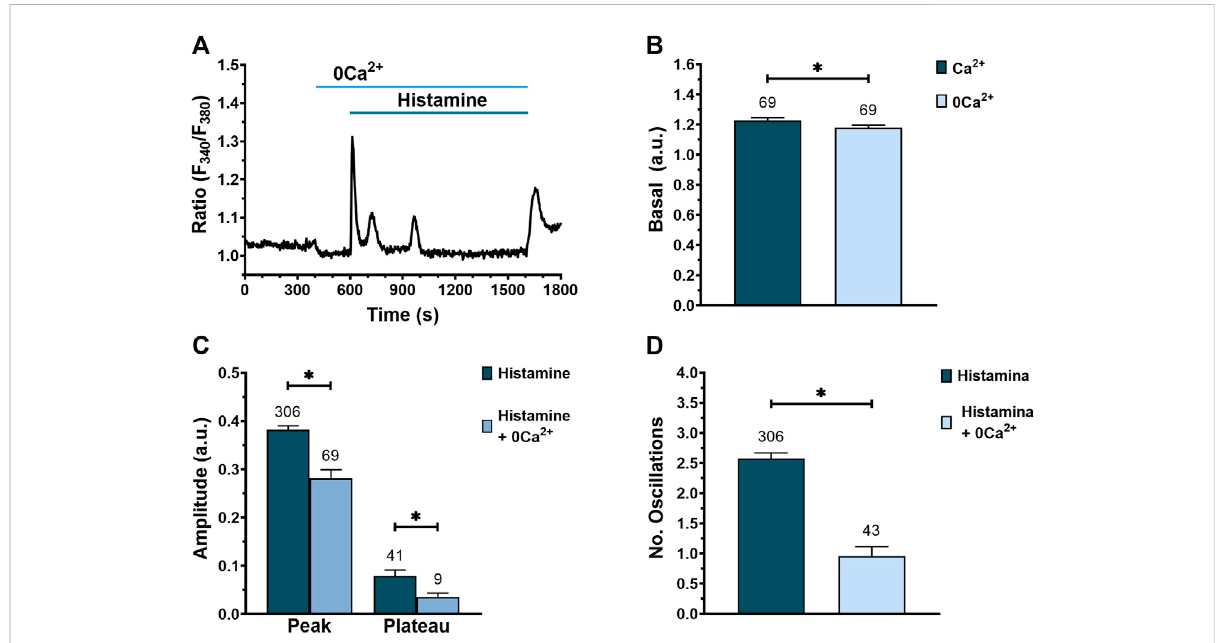
FIGURE 7 Effect of extracellular Ca 2+ removal on histamine-evoked Ca 2+ signal in WI-38 human lung fi broblasts. (A) Typical recording of histamine- evoked Ca 2+ signals in the absence of extracellular Ca 2+ (0Ca 2+ ). (B) Mean ± SE of basal [Ca 2+ ] i in fi broblasts exposed to an extracellular solution with (dark green bar) or without extracellular Ca 2+ (blue bar). Comparison between groups was performed using the t-Student test (* = p ≤ 0.05). (C) Mean ± SE of peak and plateau amplitudes of the Ca 2+ signal evoked by histamine in fi broblasts expose to an extracellular solution with (dark green bar)orwithoutextracellularCa 2+ (blue bar).Comparisonbetweengroupswasperformedusing the t -Studenttestfor peakamplitude data and Mann-Whitney test for plateau amplitude data (* = p ≤ 0.05). (D) Mean ± SE of the number of oscillations recorded during the fi rst 400 s after histamine application in an extracellular solution with (dark green bar) or without extracellular Ca 2+ (blue bar). Comparison between groups was performed using the Mann-Whitney test (* = p ≤ 0.05). The numbers in the fi gures represents the number of cells